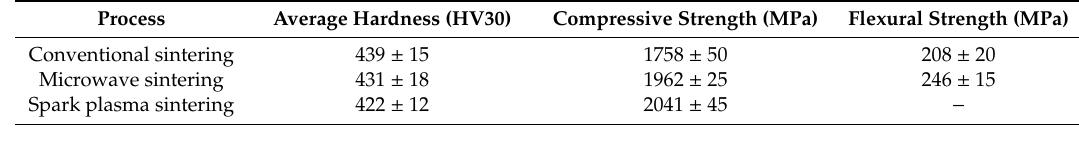
Table 5. Mechanical properties of alloy in different heating modes.